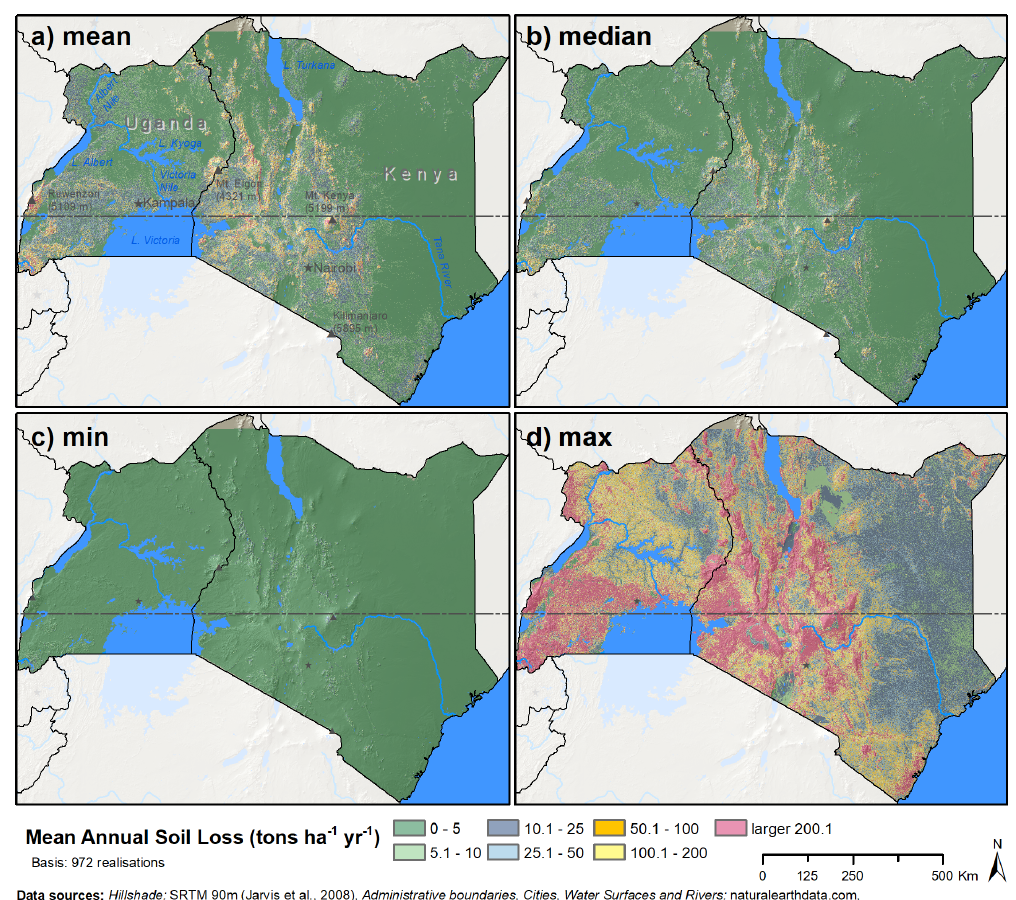
Figure 3. Descriptive statistics calculated for each grid cell based on the 972 USLE model realizations. Panels (a) to (d) show the mean, median, minimum, and maximum long-term annual soil erosion in each grid